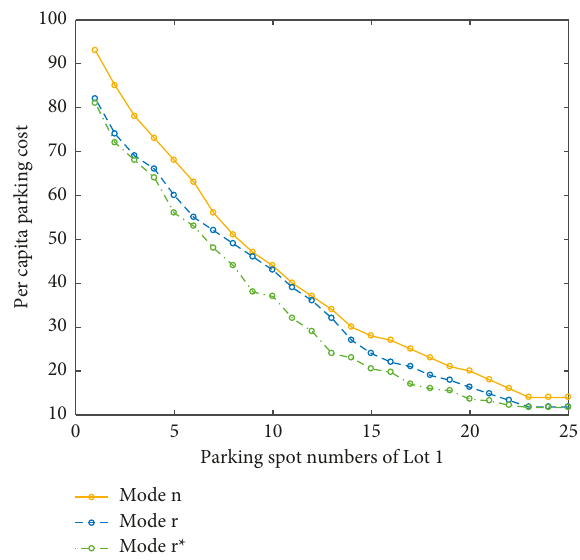
Figure 12: Per capita parking cost of travelers in the three modes.